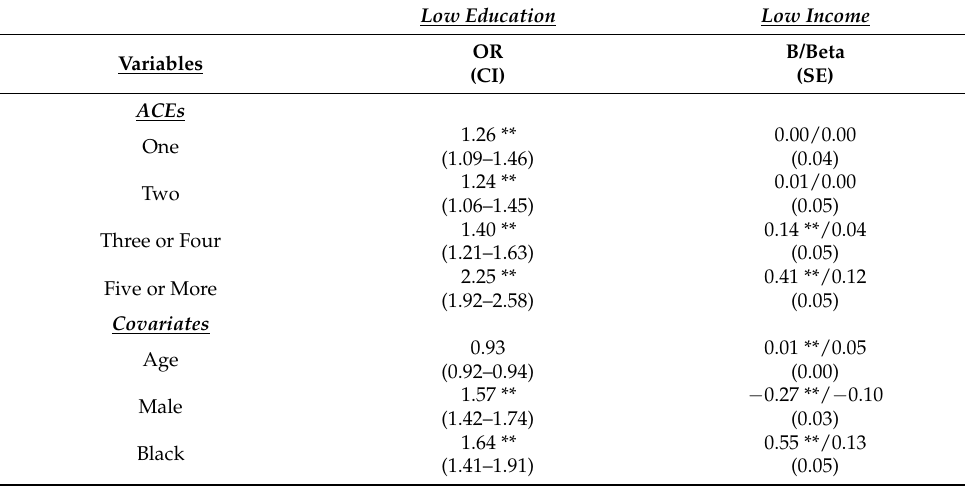
Table A5. Association between adverse childhood experiences and indicators of cumulative disad- vantage among young adults aged 18–34 ( n =